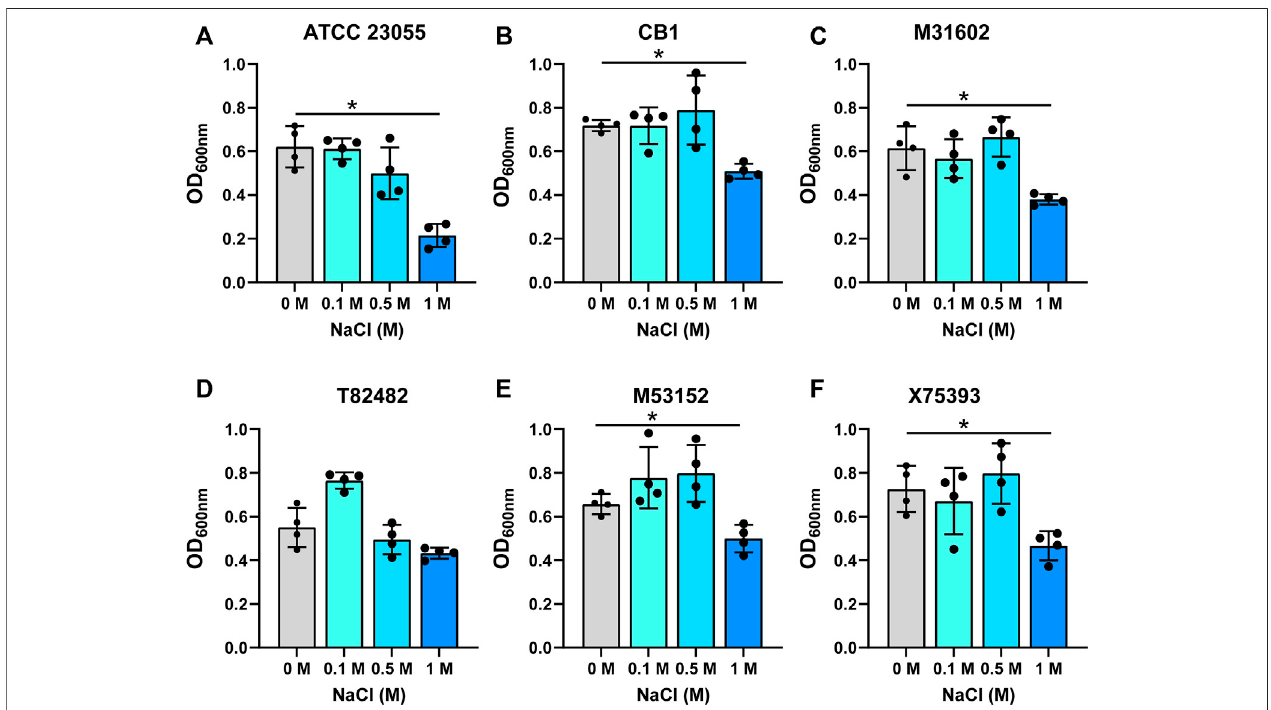
FIGURE 2 | Growth of (A) . calcoaceticus at varying osmolarity. Growth of A. calcoaceticus strains as measured by OD 600nm after 18 h of incubation. Growth was examined in the following strains: (A) ATCC 23055, (B) CB1; clinical isolates: (C) M31602, (D) T82482, (E) M53152, and (F) X75,393). * p < 0.05, One Way